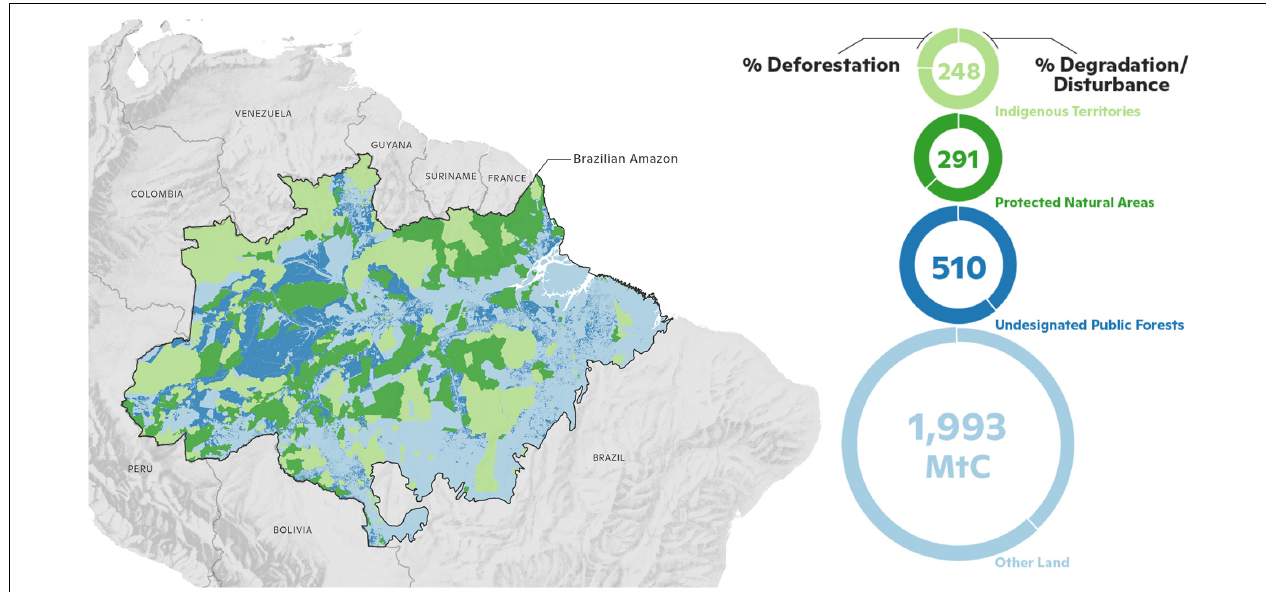
FIGURE 3 | Distribution of land tenure categories in the Brazilian Amazon (left, map), their respective emissions (right, circles), and the relative contribution of deforestation (forest conversion) vs. degradation/disturbance to those emissions (circle slices). The size of the circles represents the relative scale of emissions from each land tenure category. Land tenure data is from Azevedo-Ramos et al. (2020) and RAISG (2020). Emissions attribution data is from Hansen et al. (2013) and Walker et al. (2020).